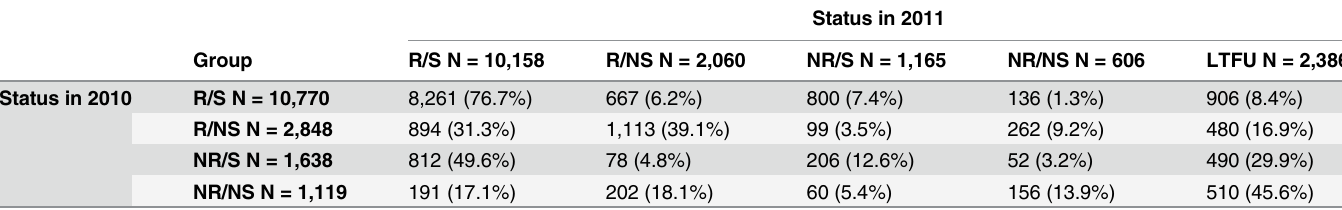
Table 2. Retention/Suppression Status in Calendar-Years 2011 by Retention/Suppression Status in Calendar-Year 2010.